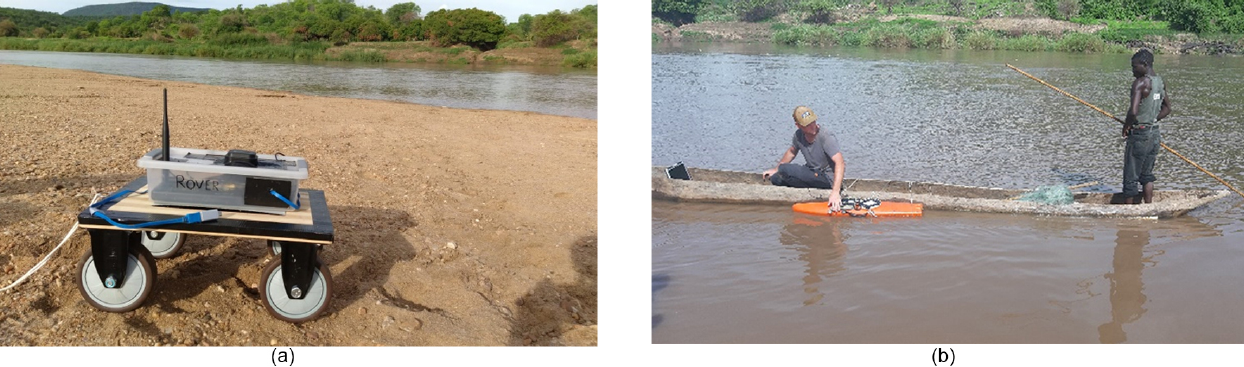
Figure 5. (a) Low-cost RTK GNSS rover mounted on a mobile cart for recording RTK waterline 5 and (b) ADCP combined with an RTK GNSS rover attached to a fisherman’s canoe measuring the wet bathymetry.